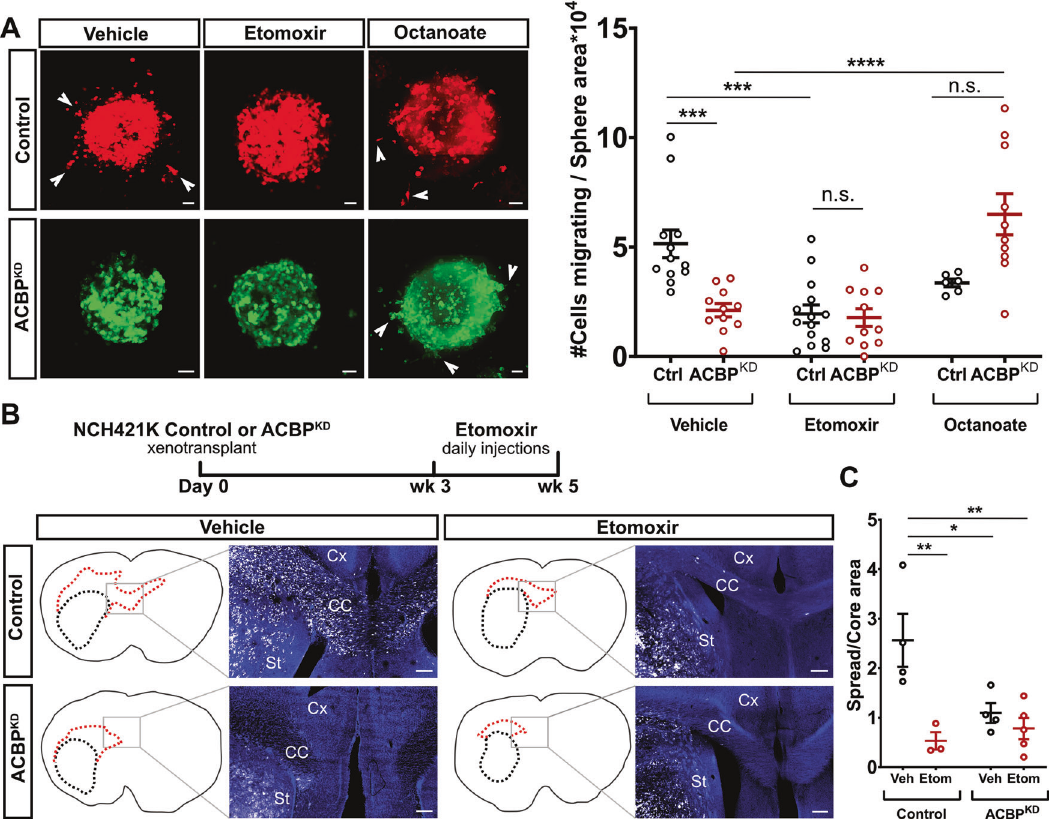
Fig. 4 ACBP KD -induced invasion de fi cit is mimicked by inhibition of fatty acid oxidation and rescued by octanoate. A Left: Representative pictures of NCH421k Control (shRNA scrambled + TdTomato) and ACBP KD (shRNA1 ACBP + EGFP) tumorspheres treated with vehicle, FAO-inhibitor Etomoxir (40 µM) or Octanoate (1 mM). Arrowheads point at invasive cells exiting the spheres. Scale bars: 50 μ m. Right: Quanti fi cation of the number of cells invading the extracellular matrix in each group, normalized by sphere size (mean ± SEM, n = 6 – 14 spheres per group, one-way ANOVA with adjusted p -value for multiple comparisons *** p < 0.0005, **** p < 0.0001). B Top: Experimental timeline for in vivo Etomoxir injections in mice bearing either Control or ACBP KD NCH421K tumors. Bottom: Outlines of representative whole brain coronal sections with core and spread tumor areas delineated with black and red dotted lines, respectively. Pictures belong to the indicated brain areas and show fl uorescently-labeled tumor cells (white) and DAPI signal (blue). St: striatum, C.C.: corpus callosum, Cx: cortex. Scale bars: 200 µm. C Quanti fi cation of spread/core area ratios per brain in each experimental group (mean ± SEM, n = 3 – 5 mice per group, one-way ANOVA with adjusted p -value for multiple comparisons * p < 0.5, ** p <